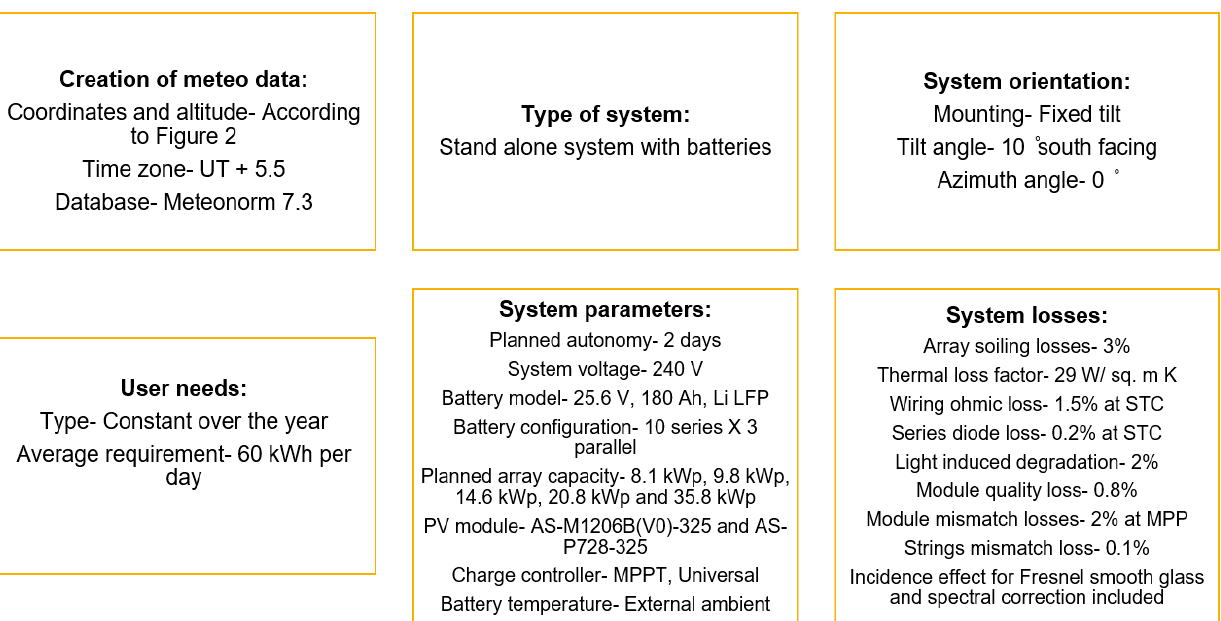
Figure 7. Simulation inputs for PVsyst 7.2 [28–30].